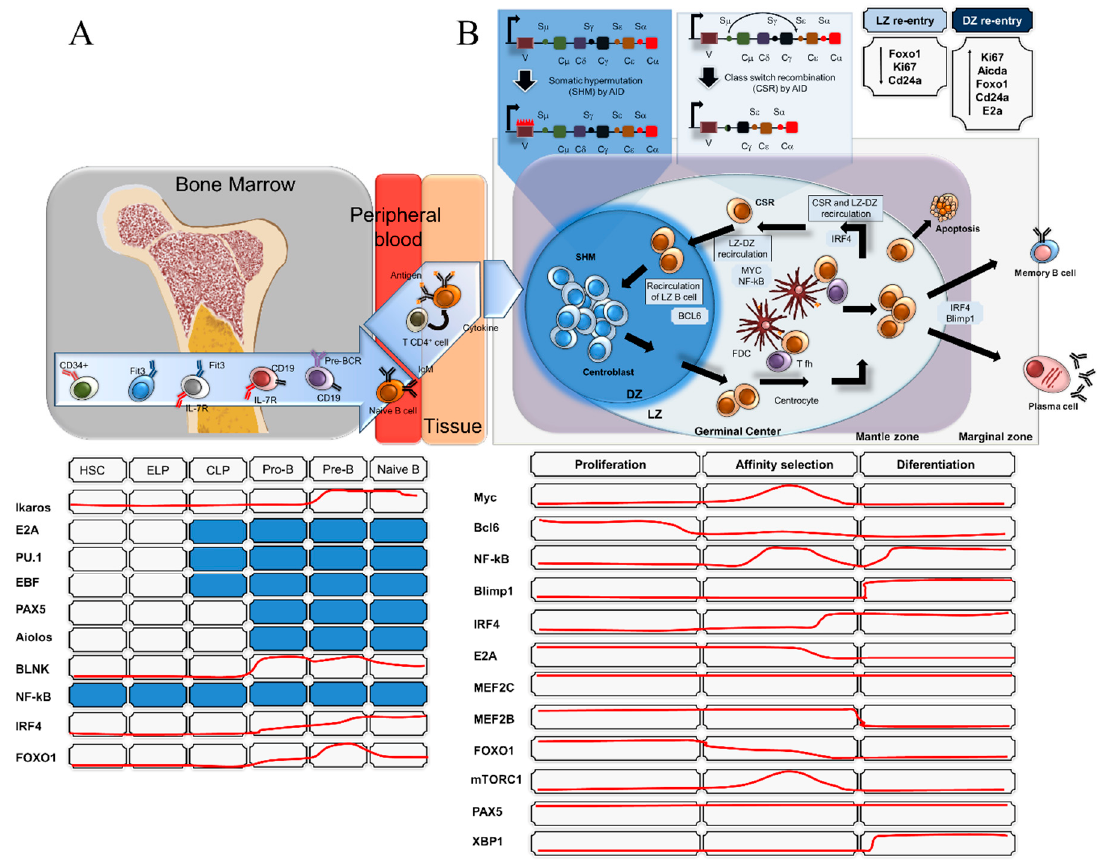
Figure 1. Transcriptional regulators involved in B-cell development and B-cell activation. ( A ) Schematic representation of the transcription factors involved in the process of B-cell development from the bone marrow to the peripheral blood and secondary lymph nodes. Naïve B-cells with successful V(D)J recombination and that express functional B-cell receptors leave the bone marrow and migrate to peripheral lymphoid tissues. ( B ) Once activated by foreign antigens, the B-cells undergo several biological processes, including activation, clonal expansion and somatic hypermutations (SHM) in the dark zone (DZ) of the germinal centres of the lymph nodes, and enter the light zone (LZ) with transcriptional modifications. In the LZ, the follicular T helper (Tfh) contributes to the process of class-switch recombination (CSR) through antigen presentation by the follicular dendritic cells (FDC), re-entering the DZ of the germinal centre. The final process of B-cell activation may lead to death by apoptosis, memory B-cell differentiation or antibody-secreting B-cells (plasma cells). The red lines represent fluctuations in transcriptional factor expression during B-cell development and activation. The blue boxes represent the detected expression in the respective phase of B-cell development.